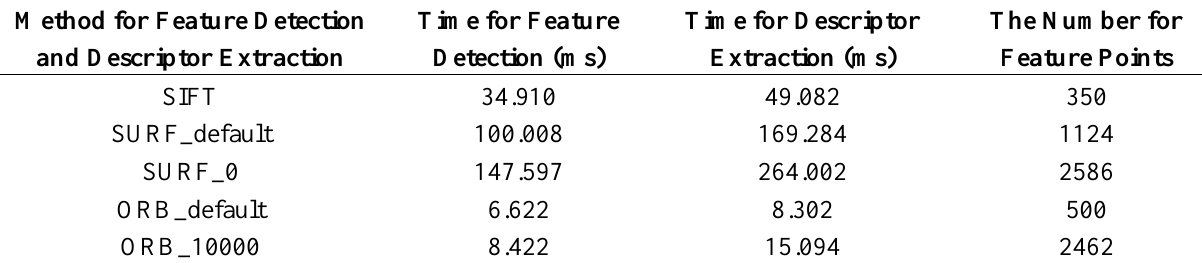
Table 3. Comparison cost times for five different methods.